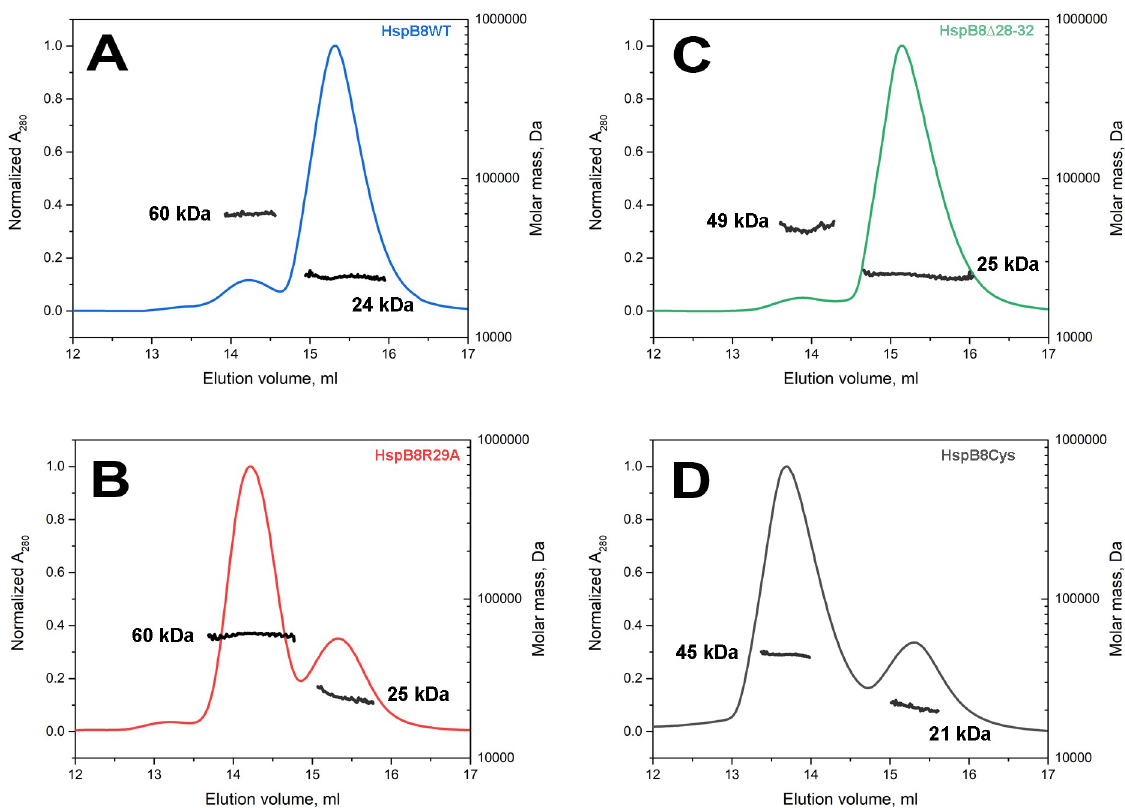
Fig 1. SEC-MALS of HspB8 WT ( А ), (blue), R29A (B), (red), Δ 28–32 mutant (C), (green) and oxidized Cys mutant (D), (black). Chromatography of HspB8 WT, R29A and Δ 28–32 mutants was performed in the presence of 2 mM DTT, whereas the oxidized Cys mutant was run without reducing agents. Numbers represent Mw (in kDa) averaged across each peak of different HspB8 species as determined by MALS.